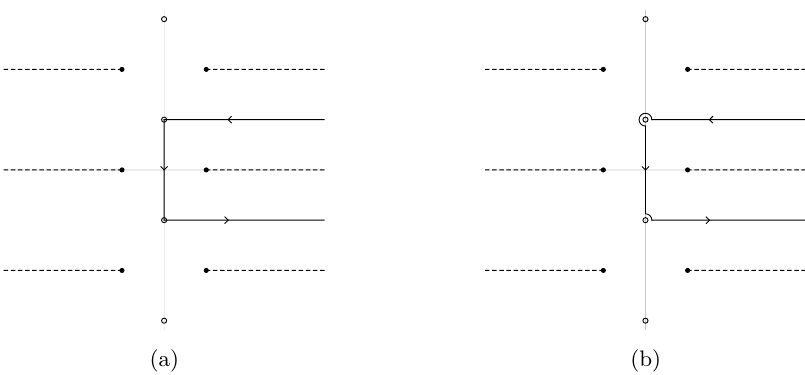
Figure 6. Singular contours. When the asymptotic imaginary part of the reflected contour shown in figure 3 reaches ± π , the contour hits the poles of the potential and becomes singular (left). 2 The singular contour must be deformed around the poles of the potential in order to define the action integral eq. (4.28). The action of the singular saddle then differs from eq. (4.33) by residues. The deformation is not unique, and one must sum over an appropriate set of singular saddles to reproduce the correct semi-classical limit. An example deformation is shown on the right, with action ˜ S 0 − 2 πiw